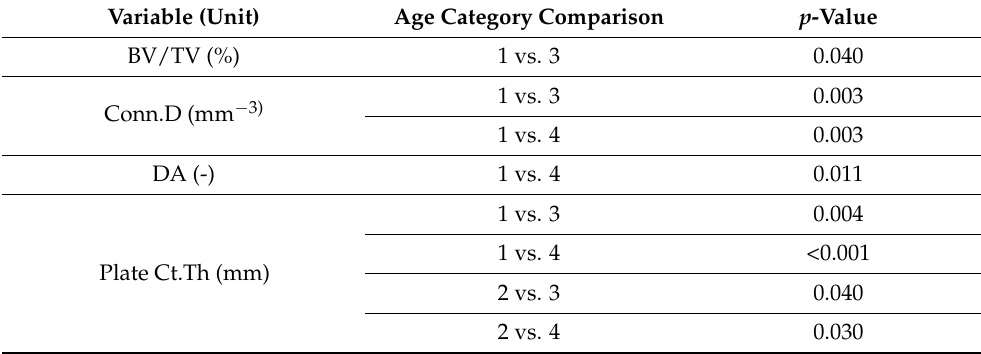
Table 6. Kruskal–Wallis post hoc test for significant age category comparisons.